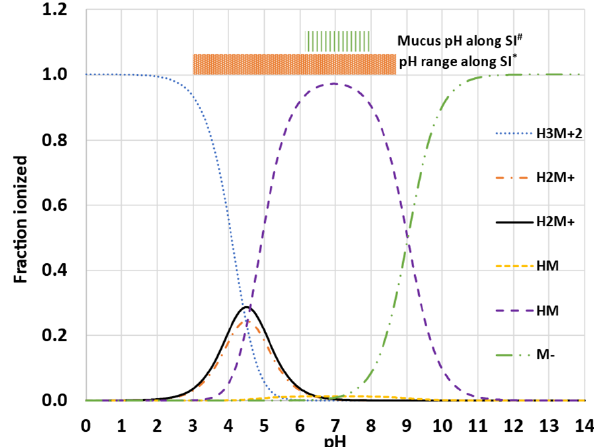
Figure 7. Predicted ionization profile of GSK254 using ADMET predictor v.10.0 (Simulation Plus, USA). The inserted horizontal bars show the range of the pH along the small intestine (SI) and the mucus. * Range of luminal pH in the SI observed in human aspirates at different regions of SI (duodenum [6,7], jejunum [7] and ileum [19]); # Mucus pH along the SI measured in porcine gastrointestinal mucus [20]. The zwitterion is indicated by the dashed line (HM).